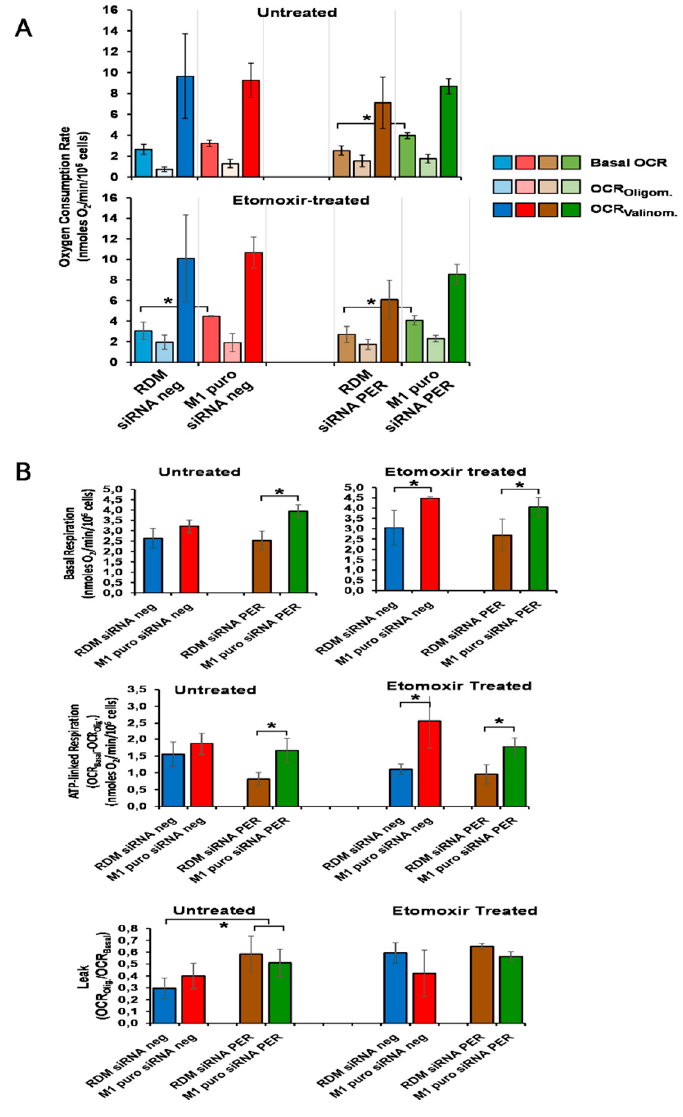
Figure 7. Effect of macroH2A1 and PER1 modulation on mitochondrial respiratory activity in HepG2 cells. Intact cells were assessed by high-resolution oximetry. ( A ) Oxygen consumption rates (OCR) outcomes. The upper and lower panel refer to OCRs measured in the absence and in the presence of etomoxir, respectively. The colored bars refer, with different tones, to basal OCR and following the addition of oligomycin and valinomycin (see legend). The values are corrected for mitochondria-unrelated respiration (expressed as nmoles O 2 /min/10 6 cells). ( B ) Mitochondrial respiration-linked bioenergetics parameters inferred from the results in ( A ). Upper bipartite panels: basal respiration on an enlarged scale; middle panel: ATP-linked respiration attained subtracting from the basal OCRs the OCROligom; lower panels: normalized respiratory leak attained as the OCROligom/OCRBasal ratio. See the Materials and Methods section for more details. RDM siRNA NEG = siRNA scramble-treated HepG2 cells; RDM siRNA PER1 = siRNA PER1-treated HepG2 cells; M1 siRNA NEG = siRNA scramble-treated macroH2A1 knocked down HepG2 cells; M1 siRNA PER1 = siRNA PER1-treated macroH2A1 knocked down HepG2 cells; bars, standard error of mean (SEM); * p < 0.05; three biological replicates were each assayed in triplicate and results were expressed as mean ± standard error of mean